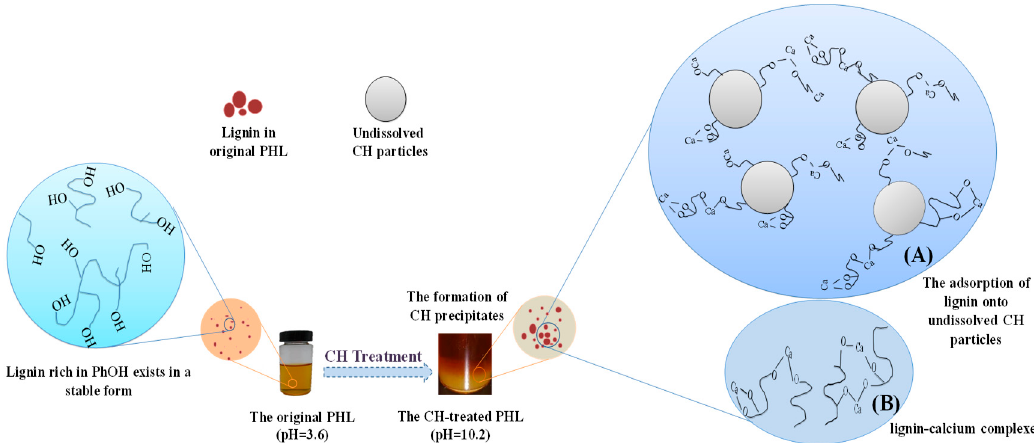
Figure 1. Schematic diagram of the formation of CH precipitates in two forms of lignin-calcium complexes and the adsorption of lignin onto CH particles during CH treatment process. ( A ) means that the adsorption of lignin onto undissolved CH particles mainly occurs during CH treatment process due to most of Ca(OH) 2 existing in solid form in PHL. ( B ) means lignin-calcium complexes between lignin and calcium ions were limited to form based on the lower solubility of Ca(OH) 2 in PHL. The significant lignin removal was obtained in CH treatment in previous research work